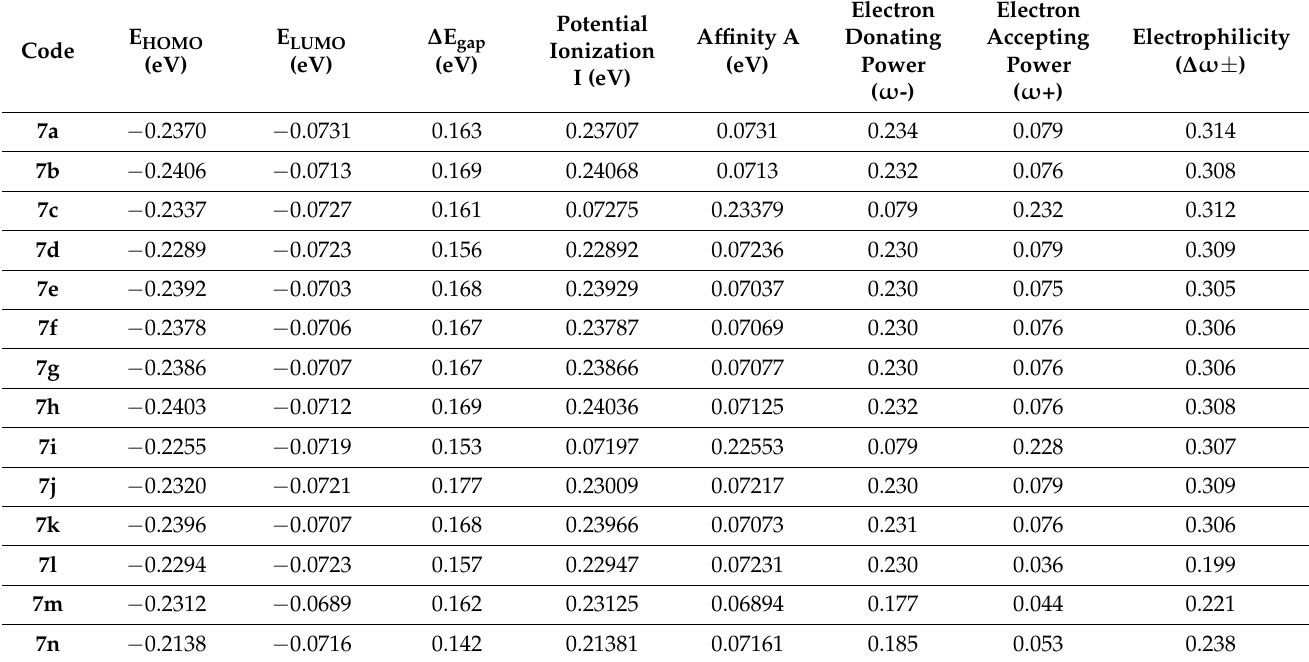
Table 2. Various Global descriptors and their calculated values for selected